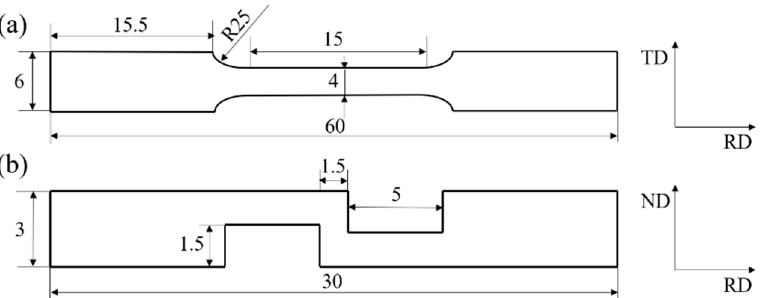
Figure 3. Schematic diagram of ( a ) tensile specimen; ( b ) tensile-shear specimen.